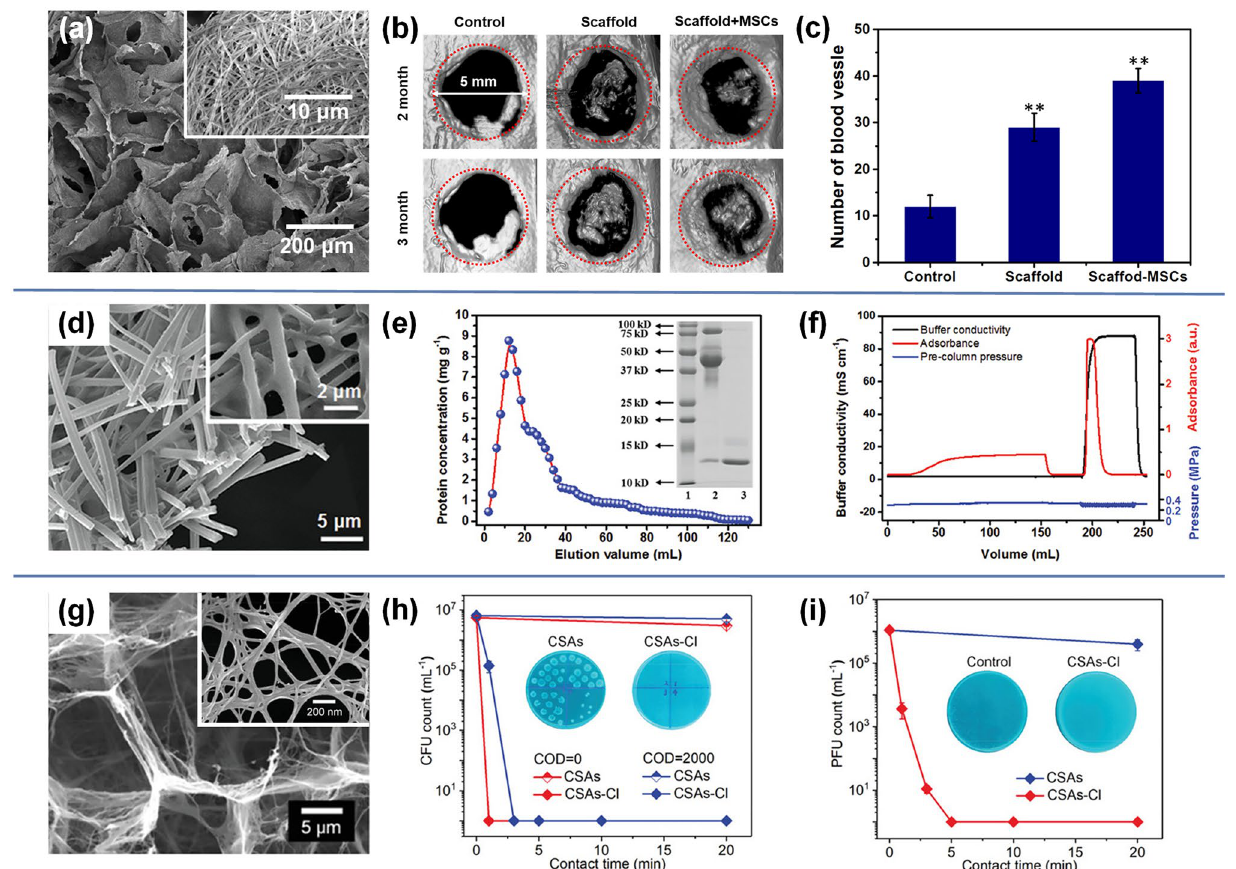
Fig. 10 a SEM image of the SiO 2 ‑CaO nanofibrous scaffold [184]. b 3D reconstructed micro‑CT images of rat cranial bone defects [184]. c Quantitative analysis of regenerated blood vessels [184]. Copyright 2019, American Chemical Society. d SEM image showing the nanofibrous cell wall of the aerogel [187]. e Dynamic elution curve of the aerogel‑packed column after extracted lysozyme from egg white. The insets are the corresponding gel electrophoresis analysis of the obtained elution [187]. f The obtained chromatogram of the prepacked aerogel column